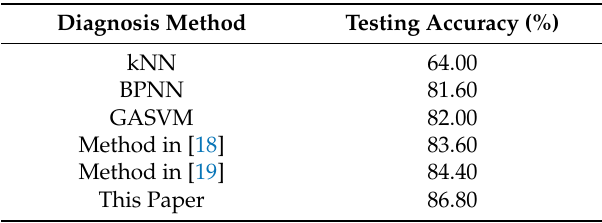
Table 9. Average testing accuracy of different methods.